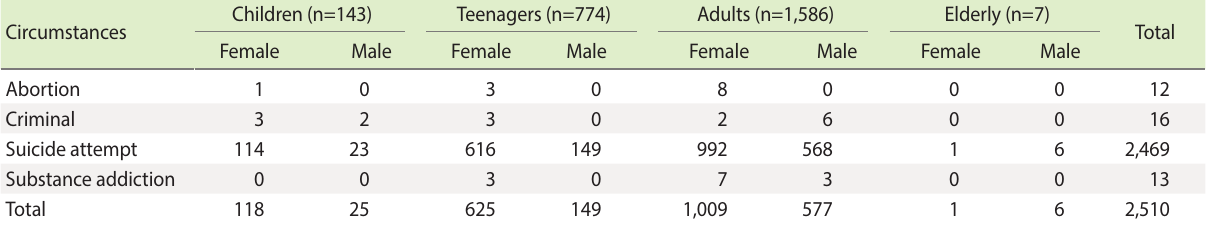
Table 2. Distribution of the circumstances of poisoning by age group